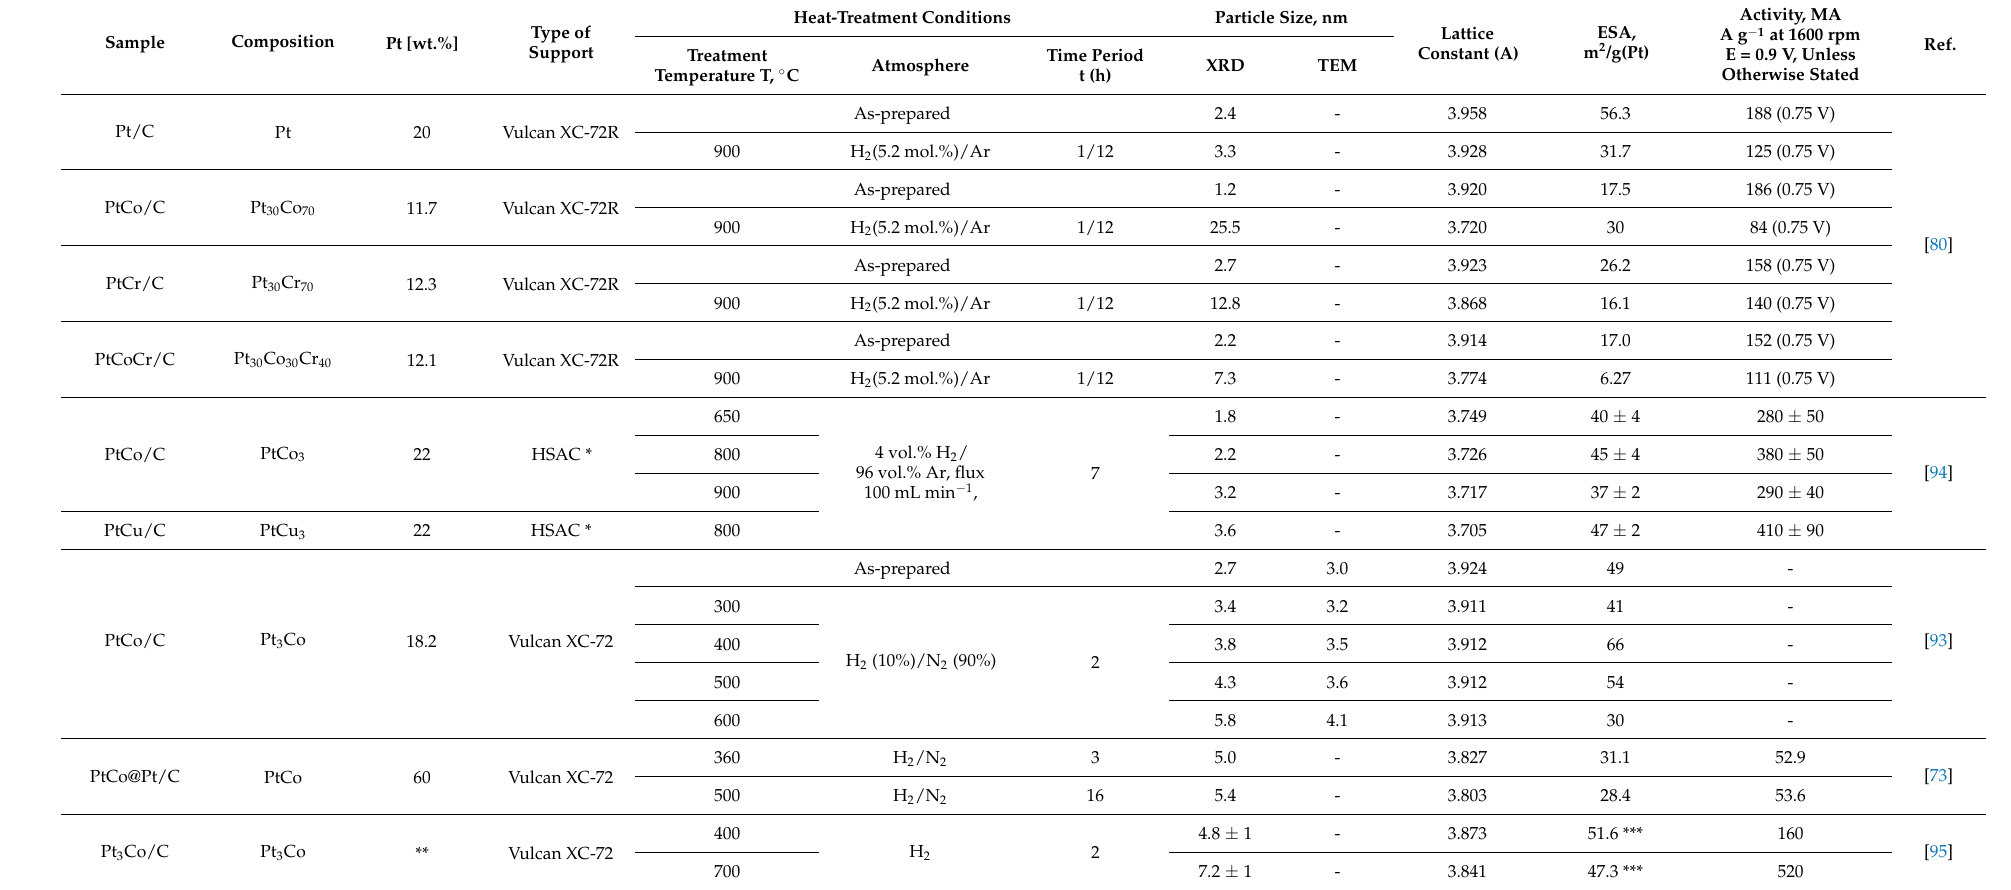
Table 3. Structural and electrochemical characteristics of bimetallic catalysts after thermal